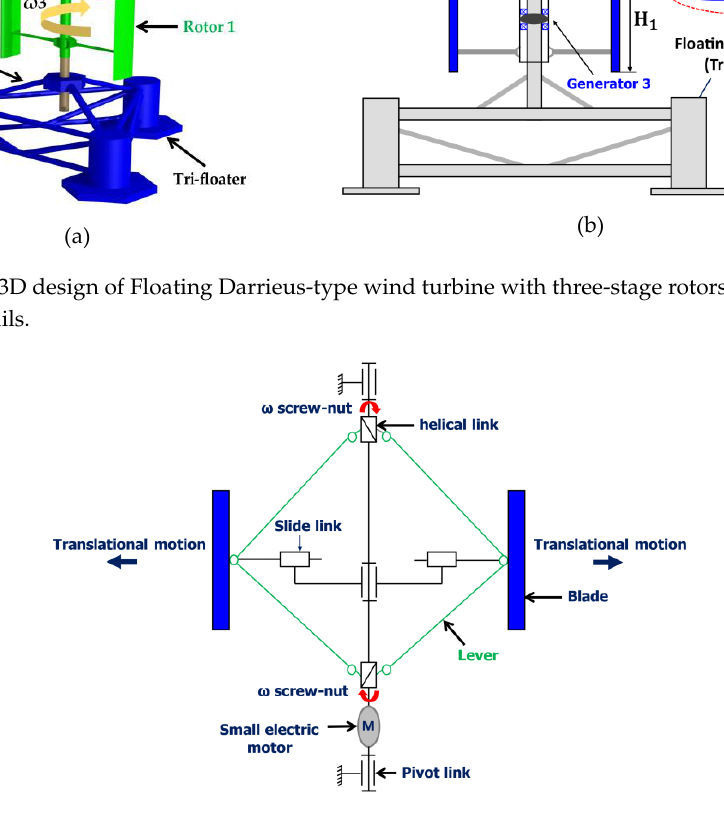
Figure 3. Kinematic scheme of the diameter variation mechanism in one rotor stage